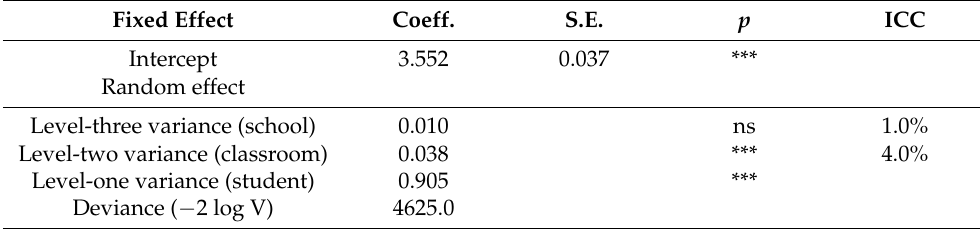
Table 2. Students’ sense of school belonging – estimates for null three-level linear